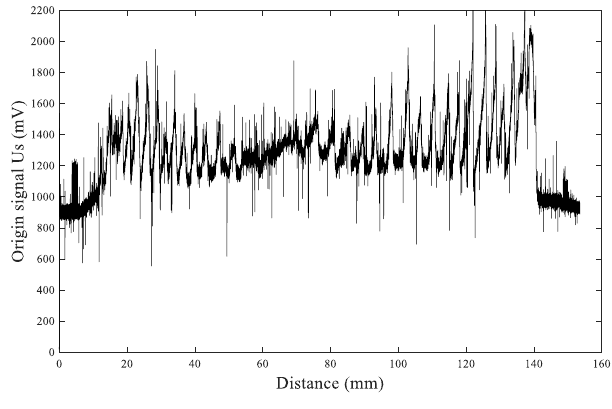
Figure 12. The original signal waveform of U s .